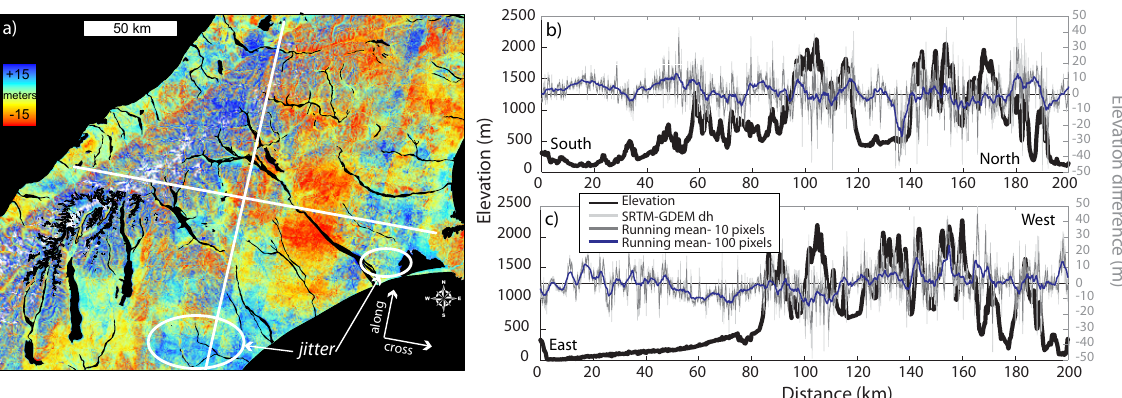
Fig. 6. Vertical differences between SRTM and the ASTER GDEM (a) . Elevation changes exemplified for along (b) and cross track (c) profiles. Significant bias of 10–15m is visible in (a) , (b) and (c) which is highly related to the number of ASTER DEMs used to compile the GDEM. Also, the bias is consistent for lengths of up to 20–40km as seen in (b) and (c) . Apparent jitter is denoted in the difference image.